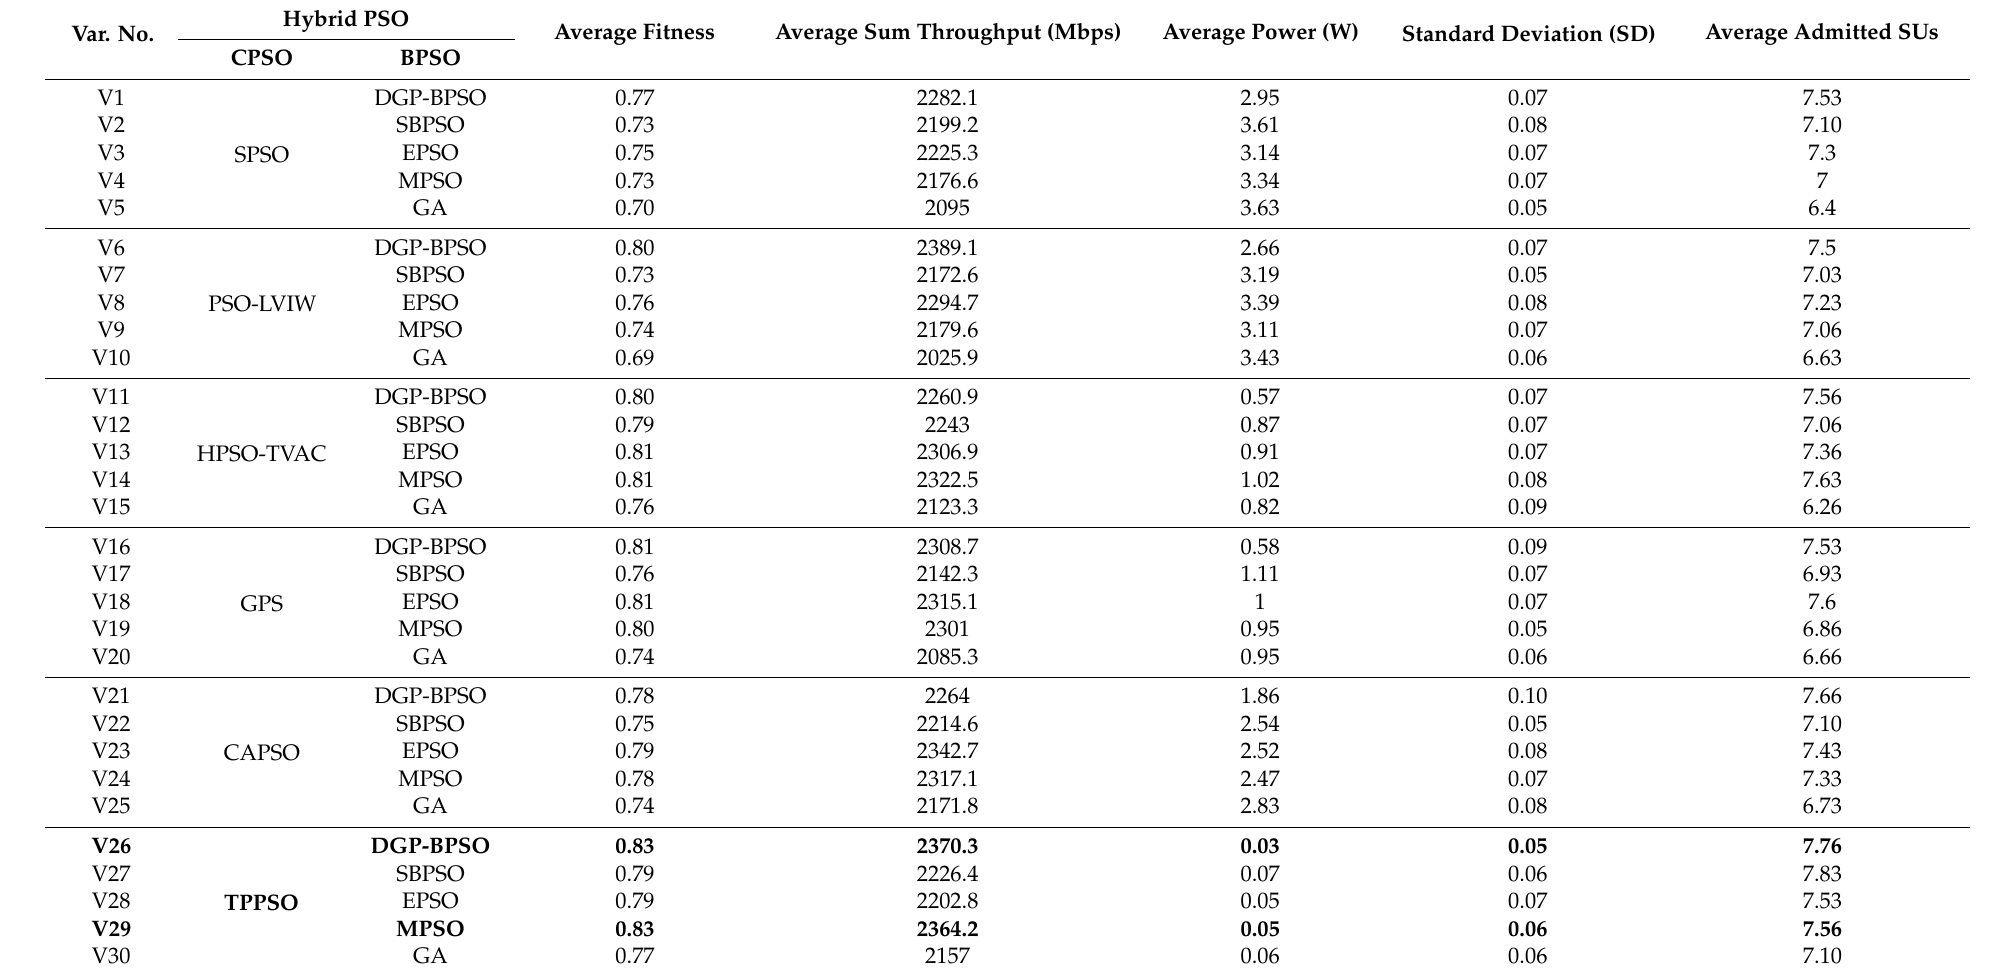
Table 6. Optimization results of the multi-objective function for Multimedia